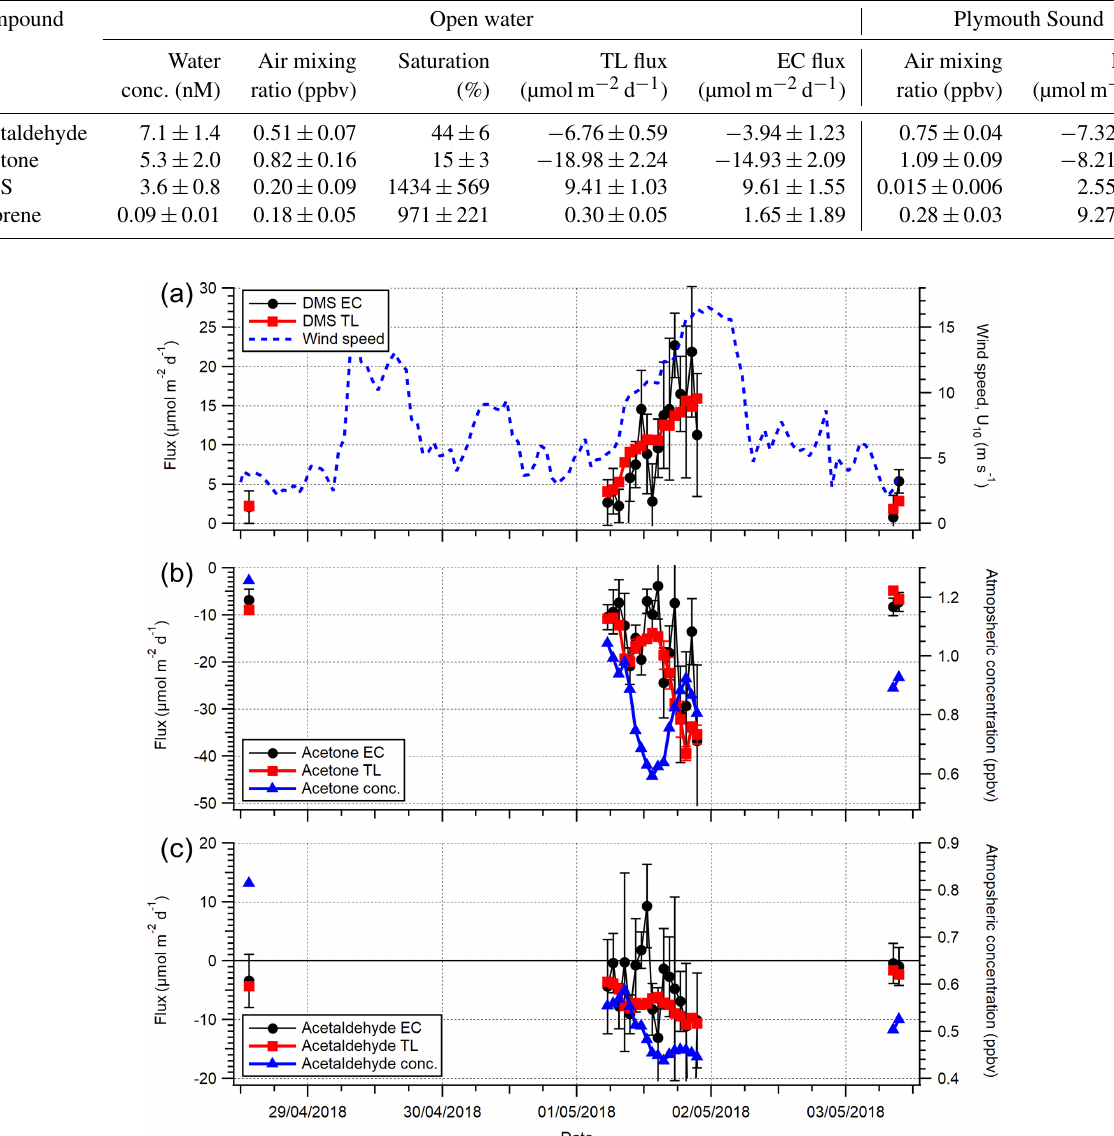
Table 2. Saturations and two-layer bulk fluxes of VOCs in open-water (SW) and Plymouth Sound (NE) water (27 April–3 May 2018) along with the eddy covariance measurements for this period. Errors for water concentration and air mixing ratio (measurement) and saturation (propagation) indicate one standard deviation. Errors for flux indicate one standard error.